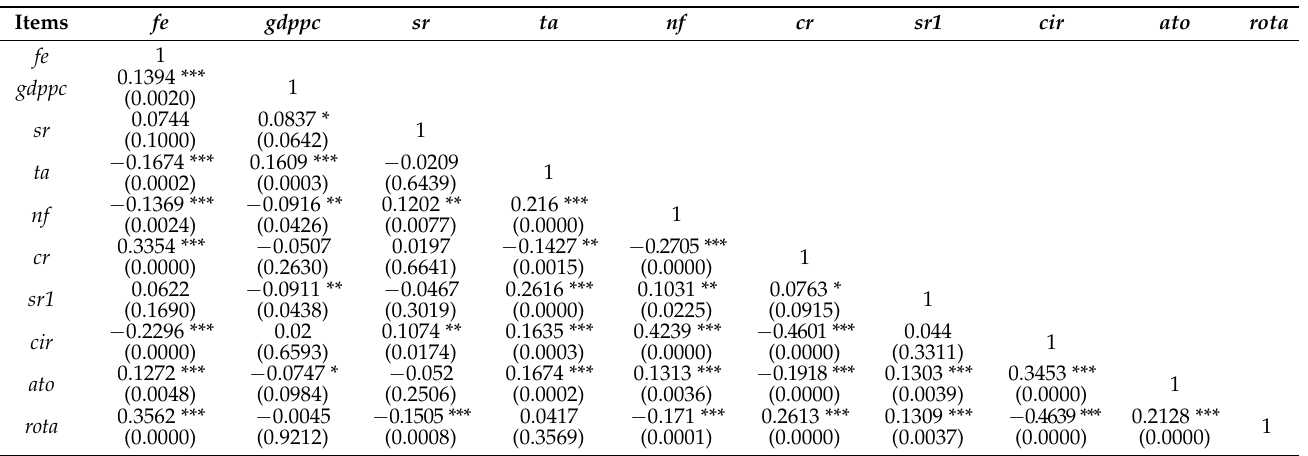
Table 5. Correlation analysis between